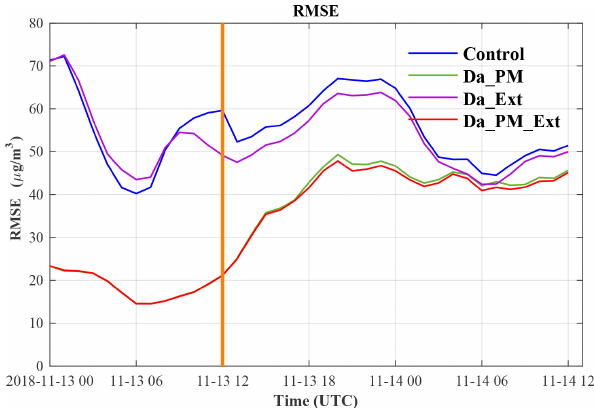
Figure 9. Variation in the RMSE of surface PM 2 . 5 MC forecasts over time (the vertical orange line separates the DA and forecast periods; the blue line signifies that obtained from the control exper- iment; the green, purple, and red lines signify that obtained from the DA_PM, DA_Ext, and DA_PM_Ext experiments,